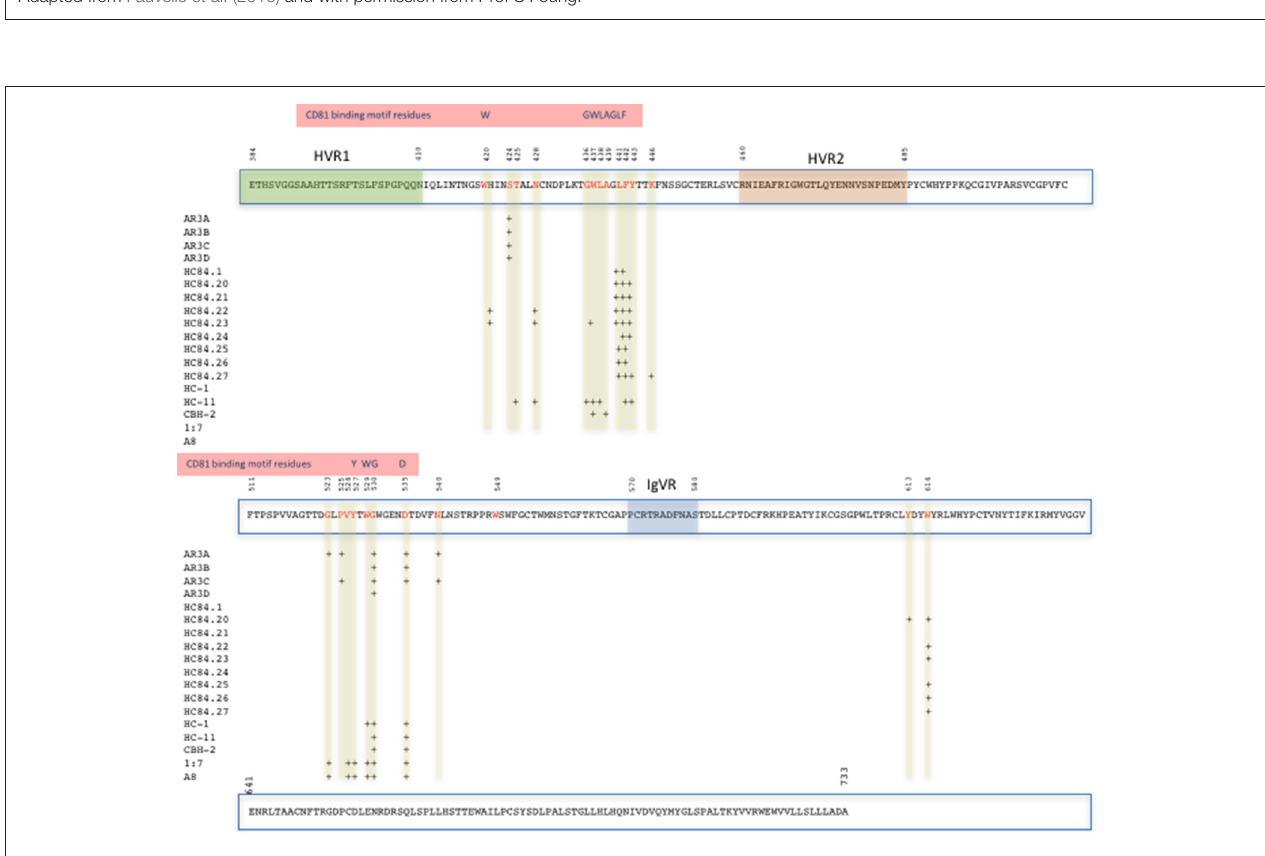
FIGURE 2 | Map of the E2 protein showing the position of amino acid contact residues (red) of HuMabs binding the Domains B and D and Antigenic Region 3 on the neutralizing face of E2 (Pierce et al., 2016). The positions of HVR1, HVR2, IgVR, and the CD81 binding motif residues on E2 are highlighted.